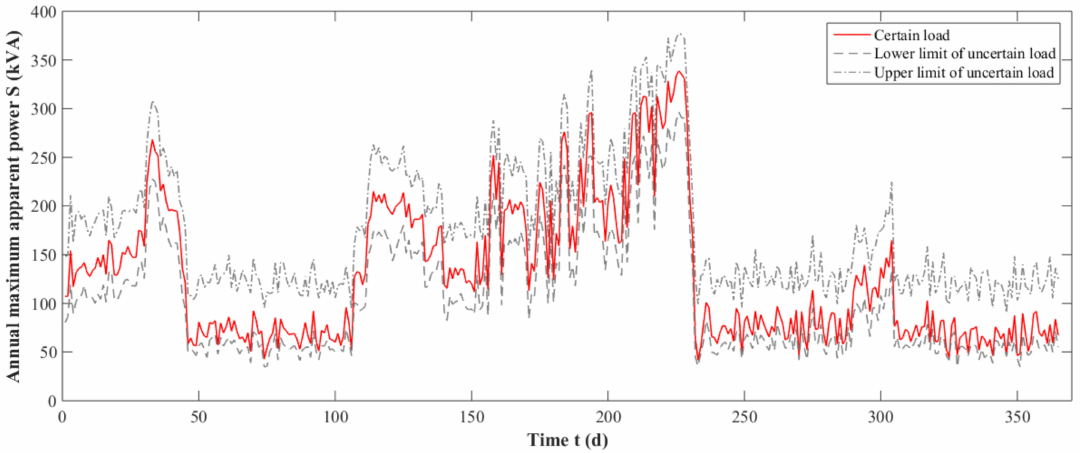
Figure 6. Variation range of annual maximum apparent power curve at node 6 in the first year of electric energy replacement.